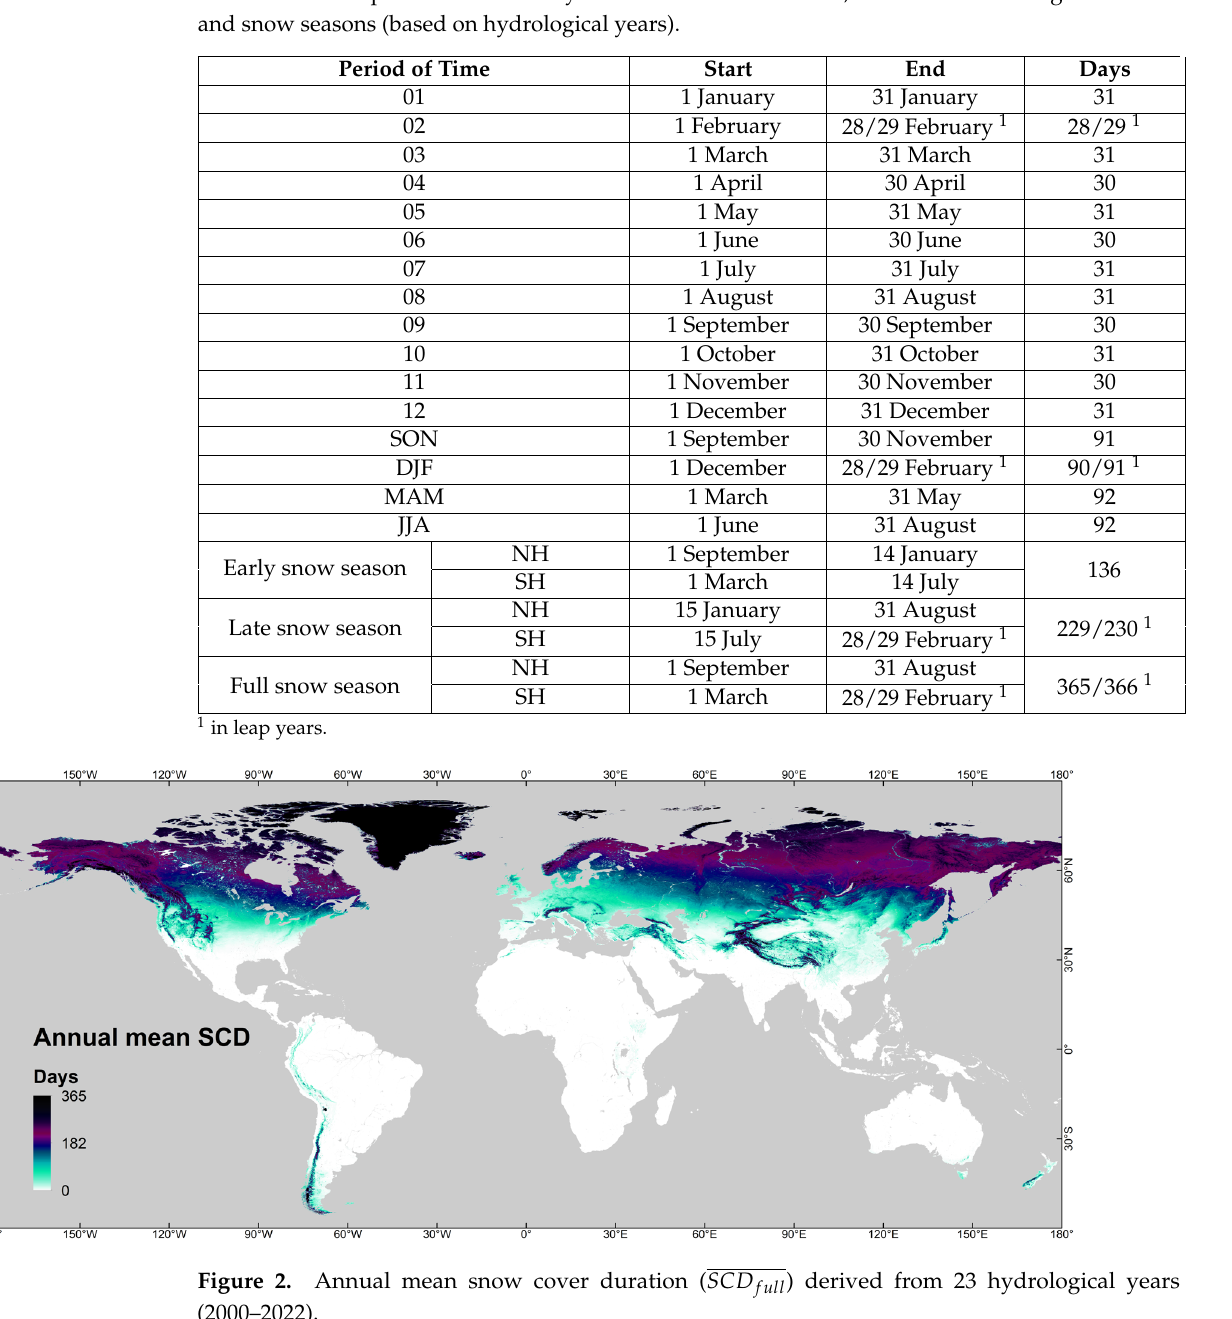
(Figure 2). For each basin,